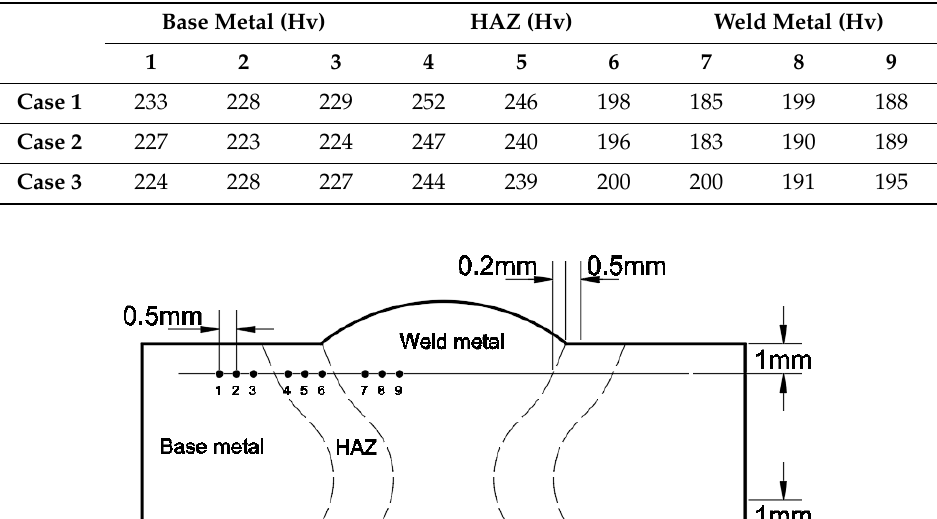
Table 7. Hardness test results for each laser welding case.